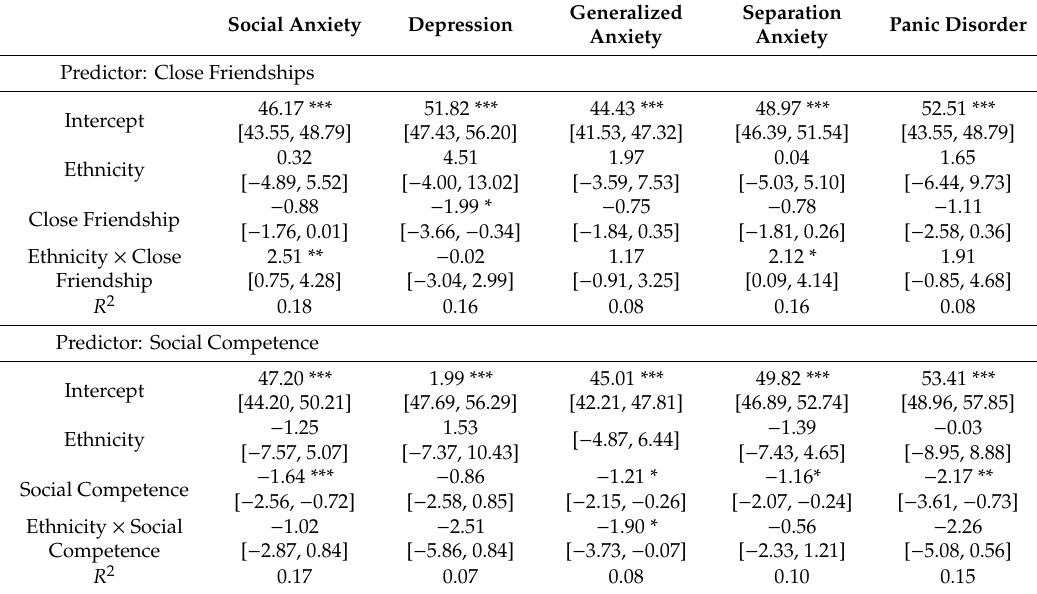
Table 4. Parameter estimates (95% Confidence intervals in parentheses) models testing ethnic group as a moderator of the relationship between close friendships, social competence and RCADS